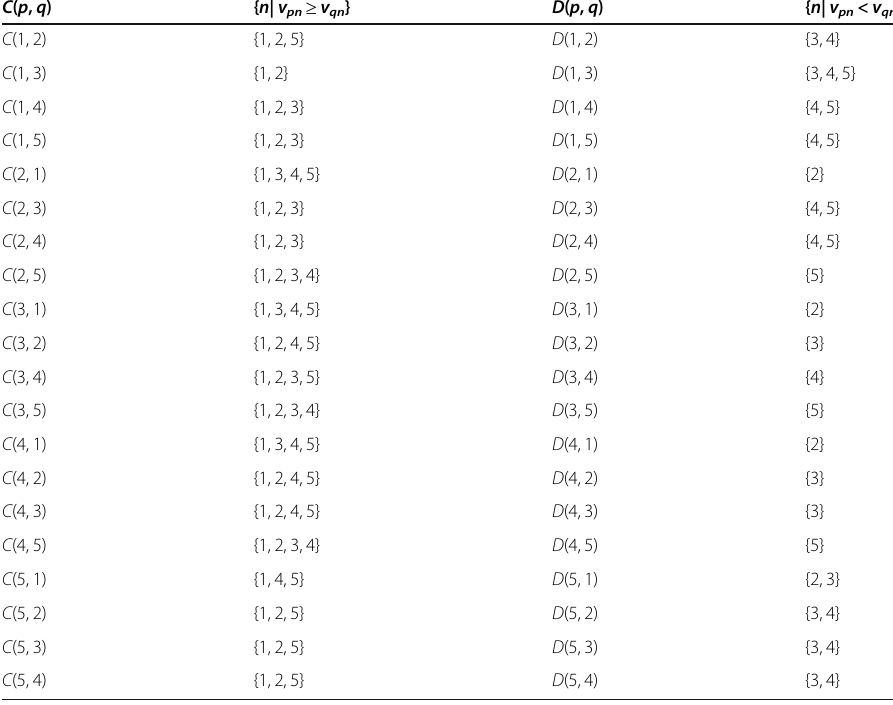
Table 6 Concordance and discordance